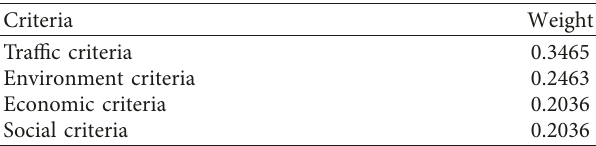
Table 2: Comparison of criteria importance.